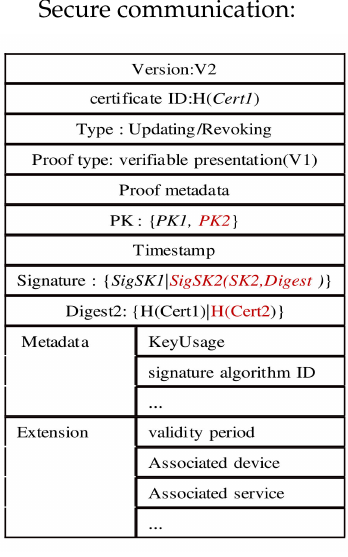
Figure 4. An example of updating and revoking